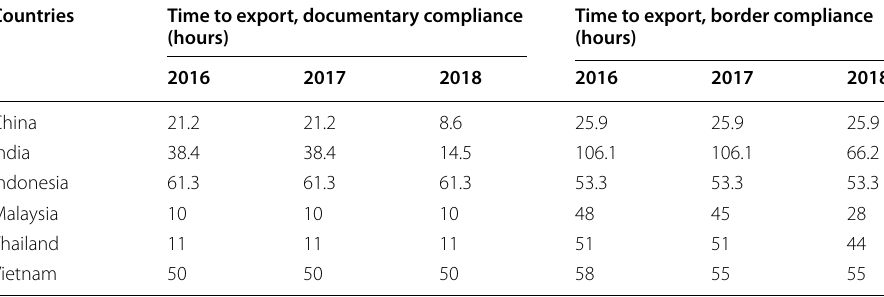
Table 2 Trade facilitation in time to export. Source: World Bank Development Indicators, 2018 Countries Time to export, documentary compliance